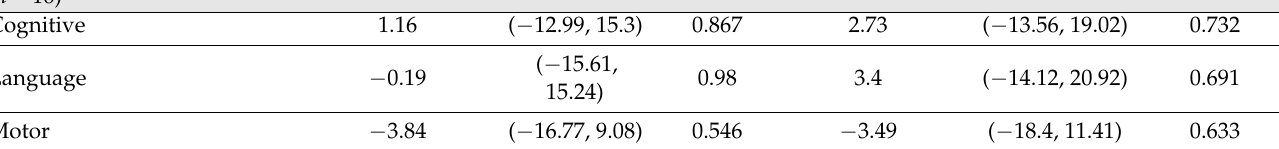
Neurodevelopmental Test